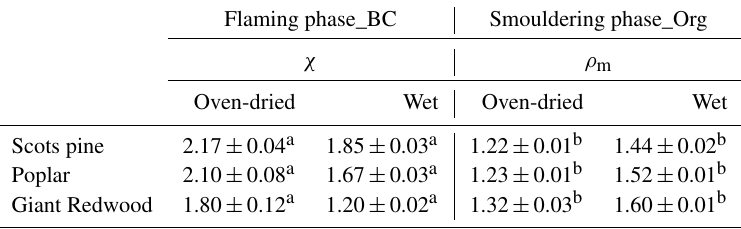
Figure 6. Mobility size distribution of monodisperse ( D a = 200nm) black carbon (flaming phase) and organic particles (smouldering phase) emitted from the combustion of the wet wood samples. Table 1. Effective density and dynamic shape factor of organic and black carbon aerosols from wood